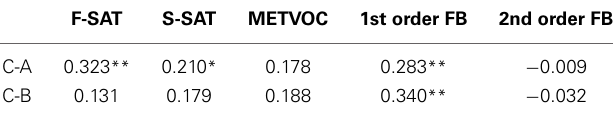
Table 3 | Partial correlations among intertemporal choice measures and the other study variables controlling for